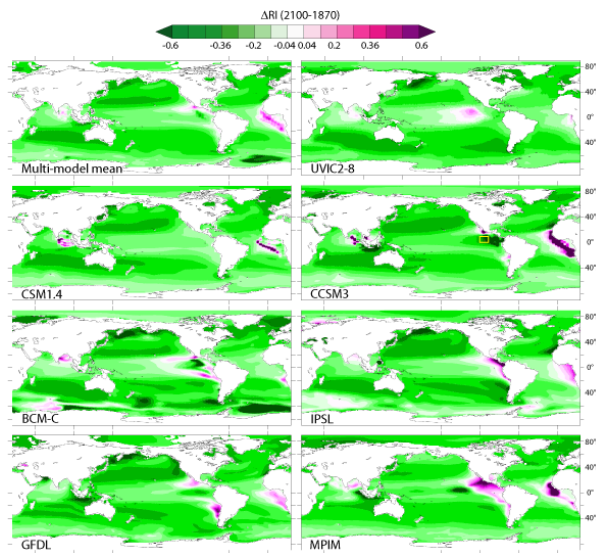
Fig. B3. Projected changes in the respiration index, RI, in the UML (100 to 600m depth) for the SRES A2 scenario. Changes are for 2100 relative to 1870. The multi-model mean change is given in the upper left panel. The yellow box refers to the region of Fig.